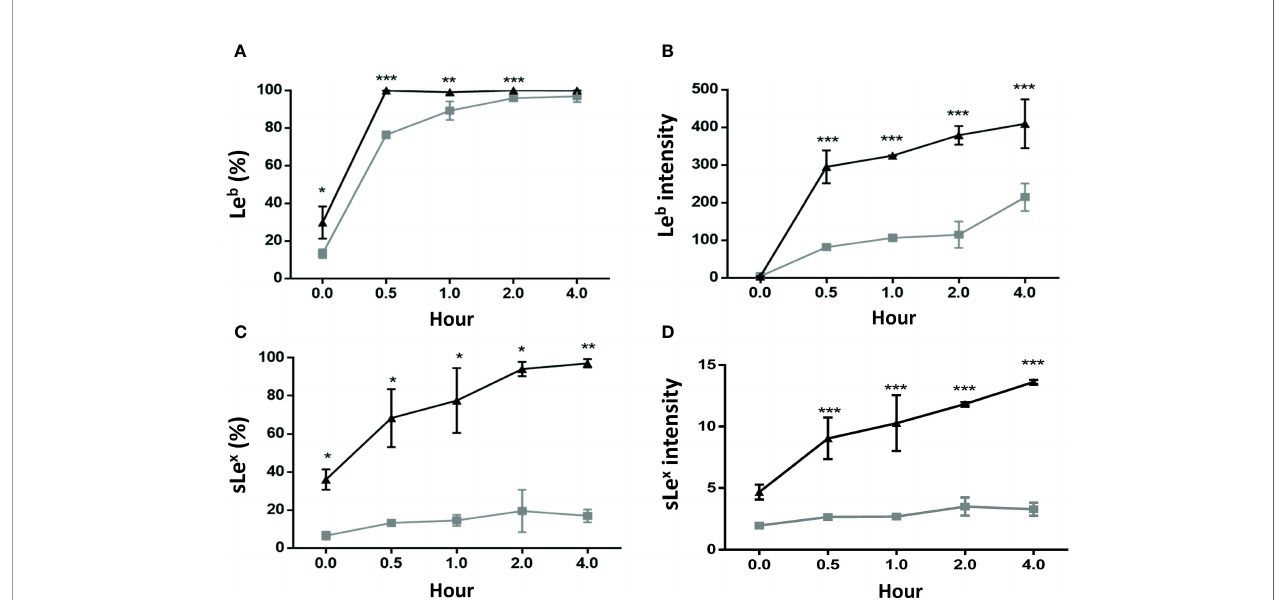
FIGURE 3 | Lewis b (Le b ) and sialyl-Lewis x (sLe x ) antigen expressions after H. pylori infection between GES-1 and HSFE cells over time. GES-1 (black triangles) and HSFE (gray squares) cells were challenged with H. pylori (MOI 100) for 0, 0.5, 1, 2, and 4 hours. The cells were washed thrice with PBS to remove unadhered H. pylori . The percentage and intensity of Le b (A, B) and sLe x (C, D) expressions were detected using speci fi c antibodies by fl ow cytometry. Data are expressed as means ± SD (in triplicate). Statistical analysis was performed for each measurement with comparisons with the HSFE cells at each time period (* P <0.05, ** P < 0.01, *** P <